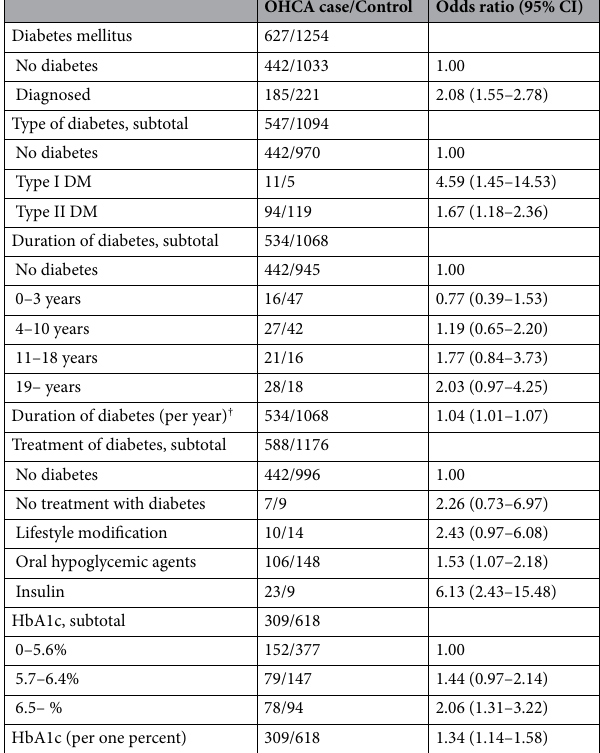
Table 4. Sensitivity analyses for the study population without covariate imputation. CI, confidence interval; DM, diabetes mellitus; HbA1c, hemoglobin A1c. Conditional logistic regression adjusted for comorbidities (hypertension, myocardial infarction, stroke, dyslipidemia, and arrhythmia) and health behaviors (current smoking status, obesity, and regular exercise during the last year). † For patients without diabetes, the duration of diabetes was